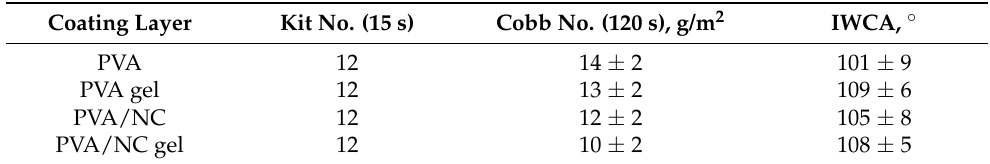
Table 2. Grease and water barrier of coated paper (coating weight: 4 g/m 2 ).